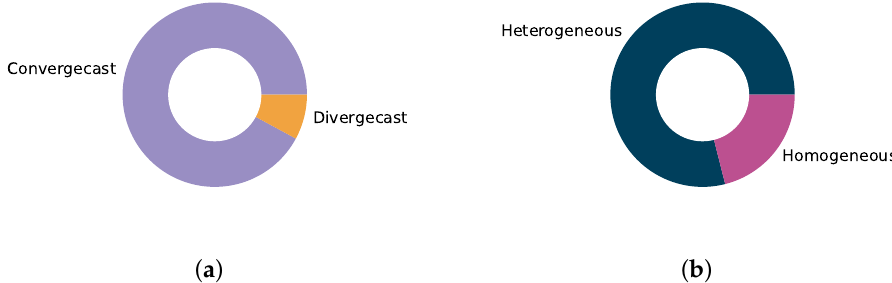
Figure 9. Distribution of evaluated traffic scenarios in schedulers. Divided into patterns , i.e., where traffic flows, and profiles , i.e., the intensity of each flow, as suggested by [69]. ( a ) Traffic patterns; ( b ) Traffic